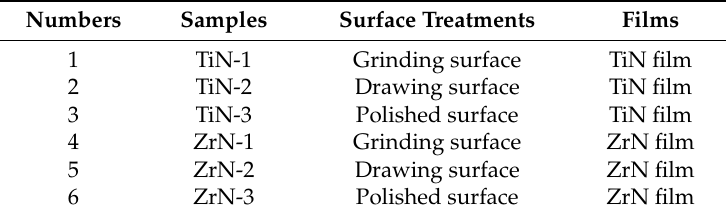
Table 1. Surface treatments for samples deposited by the arc ion plating (AIP)